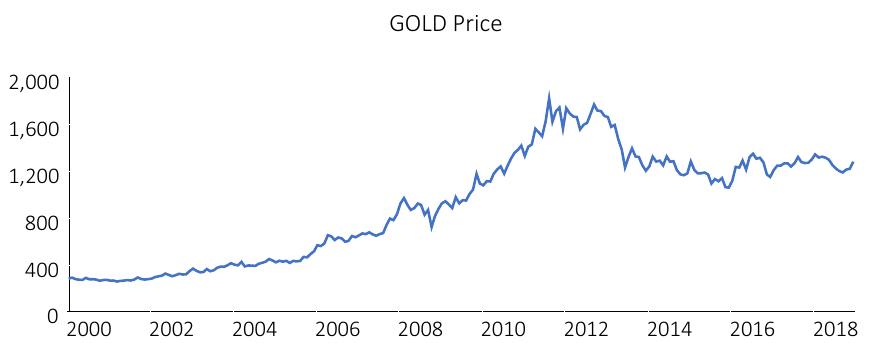
Figure 2. The Thai baht exchange rate (baht per US dollar) during 2000–2018